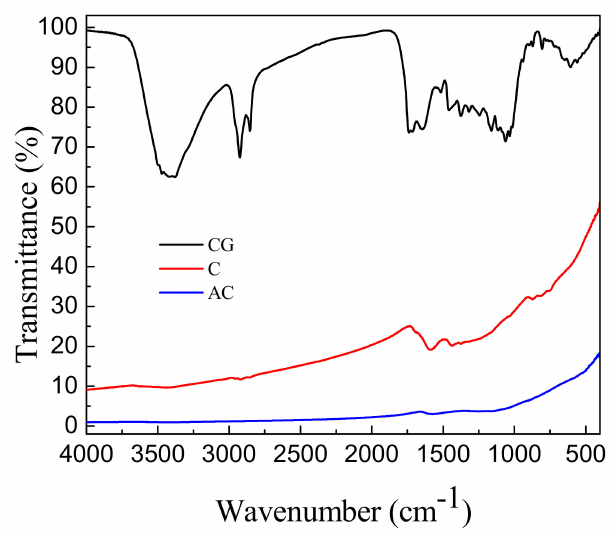
Figure 6. FTIR spectra of coffee grounds (CG), carbon precursors (CP), and activated carbons (AC).